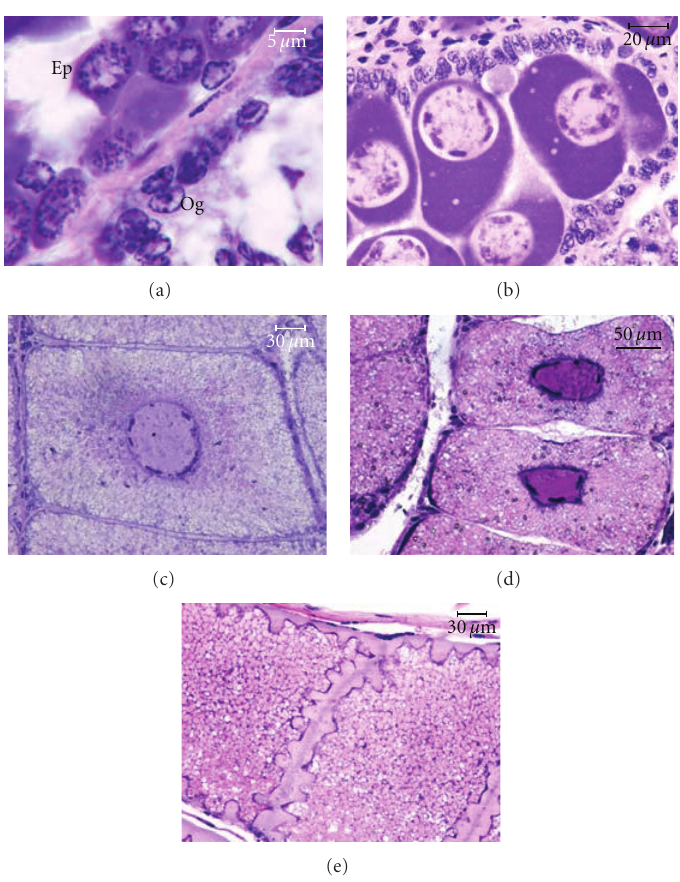
Figure 5: Oocyte developmental stages of Aristaeomorpha foliacea . (a) Oogonia (Og) and early primary stage (Ep); (b) late primary stage; (c) early vitellogenic stage; (d) late vitellogenic stage; (e) post-vitellogenic stage.